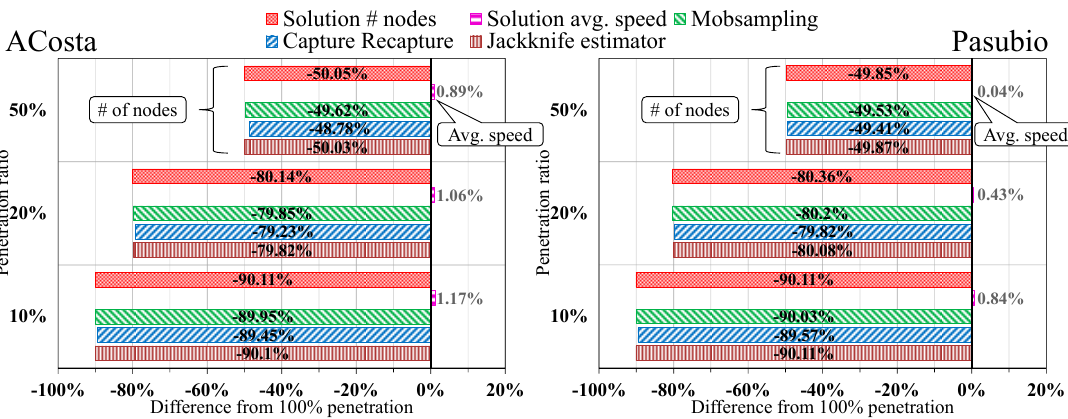
Figure 5. Concise overview of the performance difference in the two considered scenarios and against the complete penetration rate case.